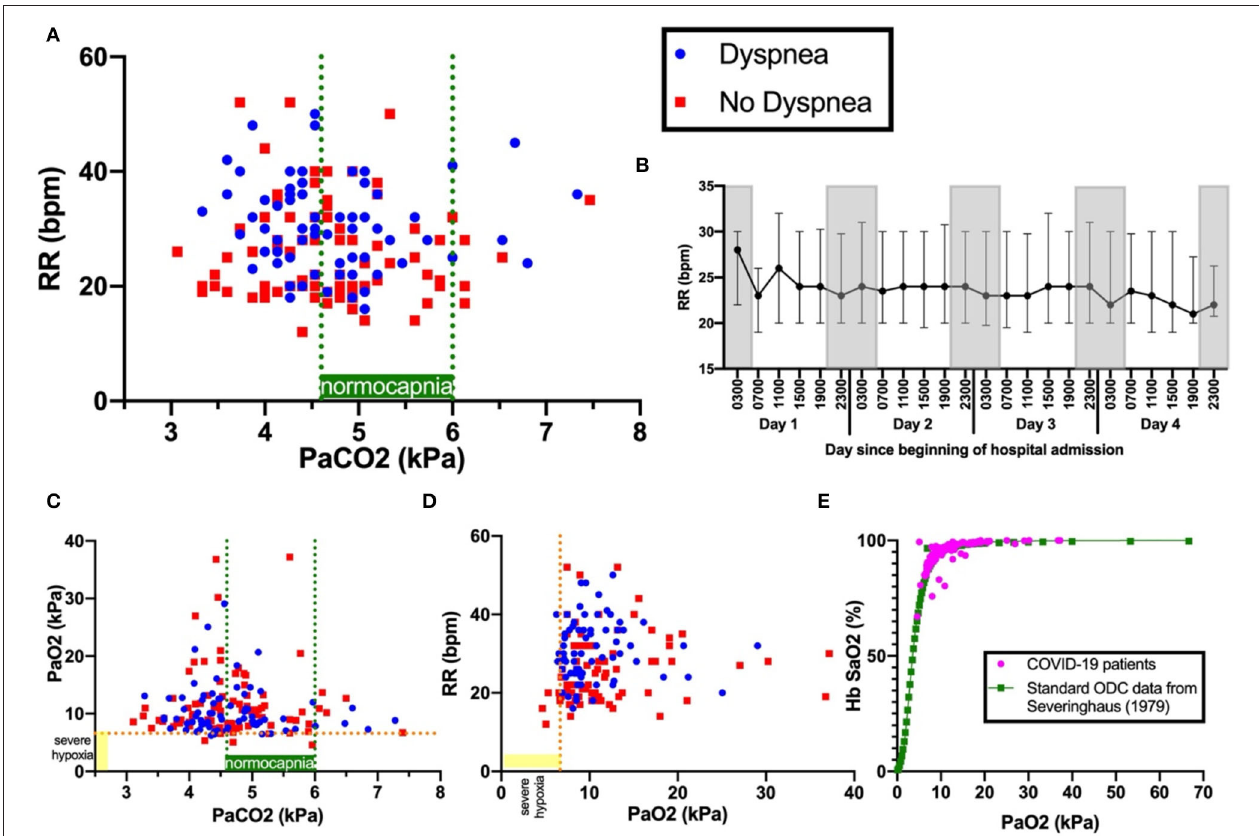
FIGURE 1 | Panel (A) shows PaCO2 versus RR. Blue dots indicate patients with dyspnoea; red squares, patients with no dyspnoea. Dashed green lines indicate boundaries of normocapnia (4.6kPa and 6.0kPa). Dashed orange line indicates severe hypoxia at 6.6kPa, a level sufficient to drive ventilation. Panel (B) shows the 4-hourly RR (median and interquartile range) over the first 96 hours since admission. Gray-shaded boxes indicate night. Panels (C) show PaCO 2 versus PaO 2 and (D) PaCO 2 versus RR. Panel (E) shows the oxygen dissociation curve (ODC) of Covid-19 patients in this cohort plotted against standard human ODC data from (14), showing no shift.